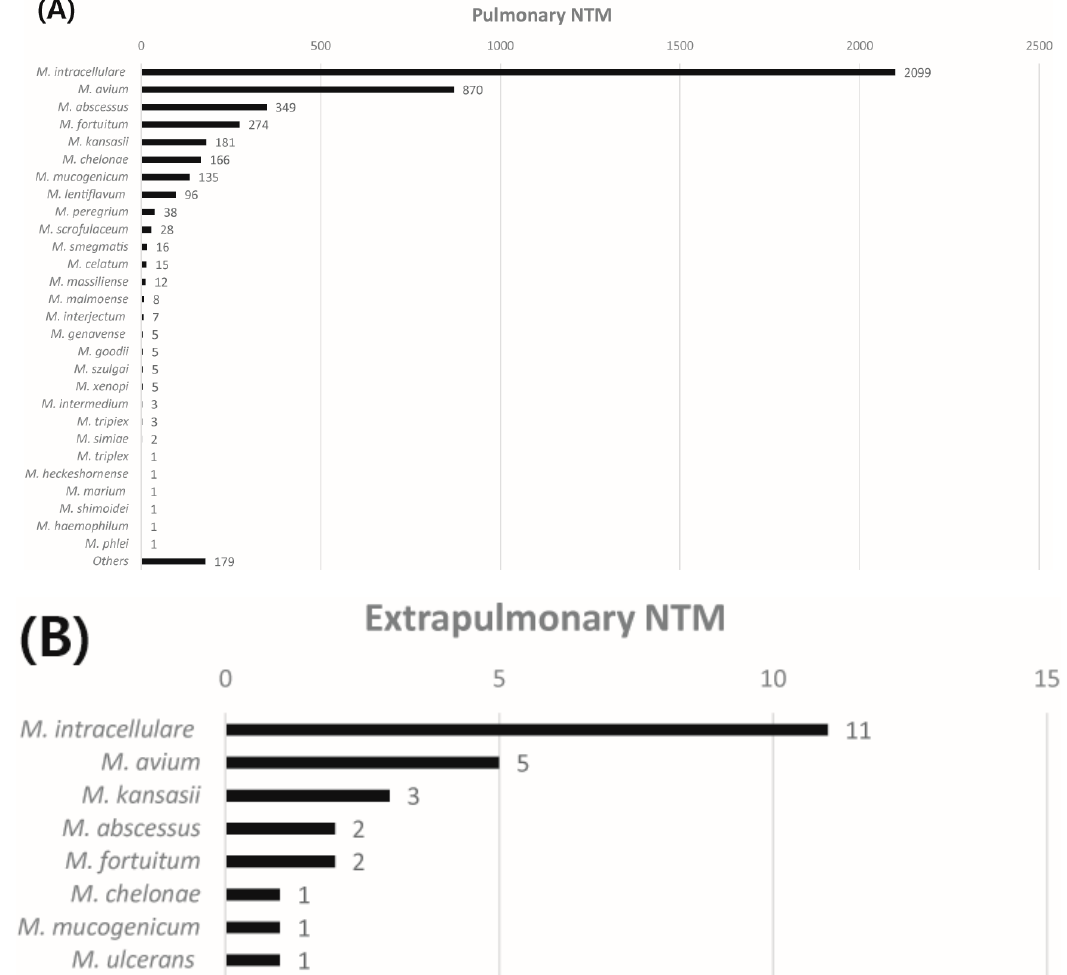
Figure 2. Distribution of nontuberculous mycobacteria species according to ( A ) pulmonary sites and ( B ) extrapulmonary sites. NTM: Nontuberculous mycobacteria.